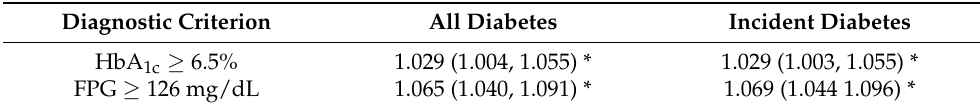
Table 2. Hazard ratios (95% CIs) a for diabetes mellitus associated with a 1 µ g/m 3 increase in annual b average PM 2.5 by diagnostic test.